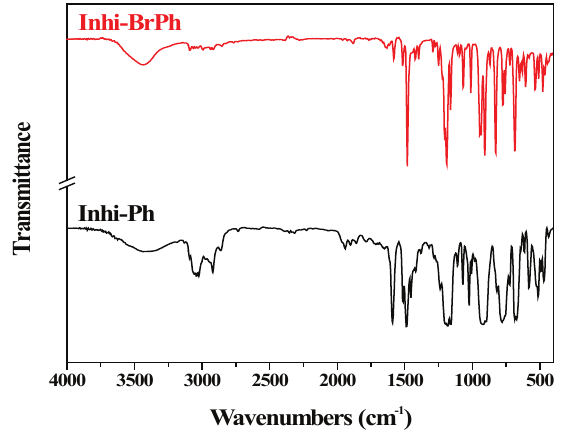
the y-axis of Figure 1 and 7. Additionally, the actual units of the charge transfer resistance should be R R (Ω cm -2 ). Corrected versions of the Figures and Table are p presented below.